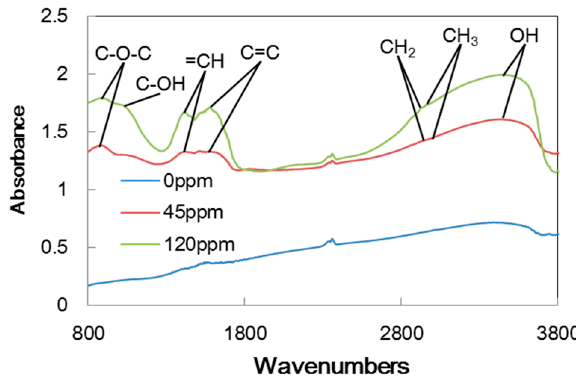
Figure 11. FT-IR spectrum of the aluminum surface slid against ta-C DLC in argon. Table 3. Peaks found in FT-IR spectra on pins slid against ta-C DLC.